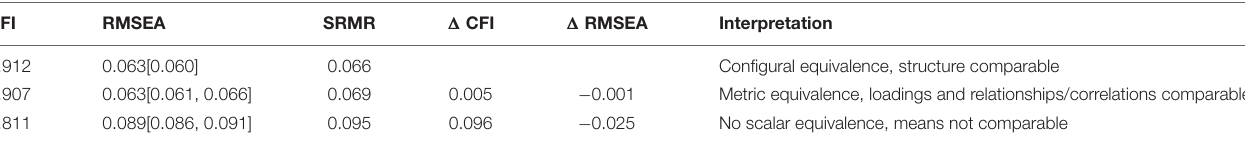
TABLE 4 | Model fit across levels of equivalence.